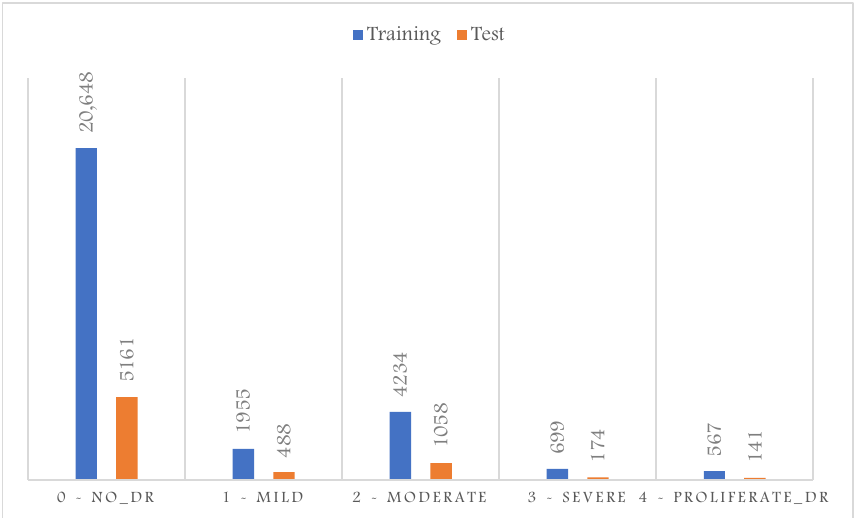
Figure 2. Original DR dataset distribution.